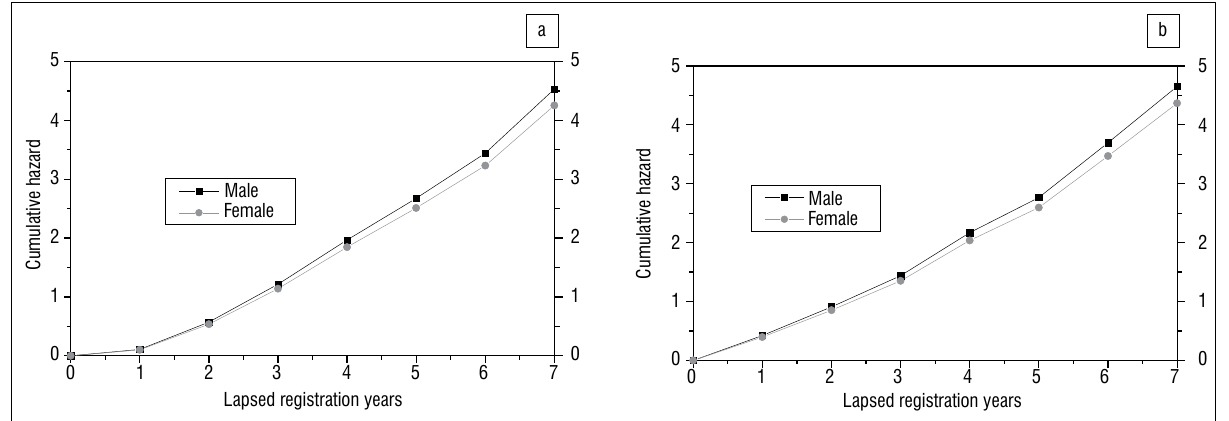
Figure 4: Cumulative hazard functions by gender for master’s students who (a) graduated or (b) dropped out of study at the University of